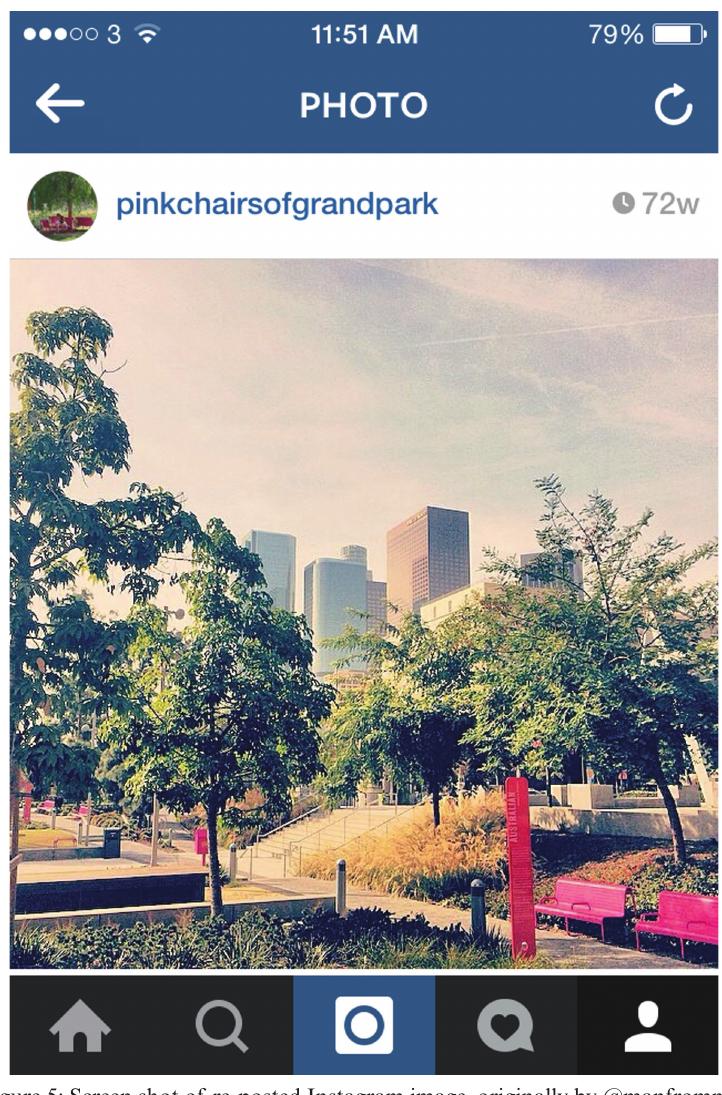
Figure 5: Screen shot of re-posted Instagram image, originally by